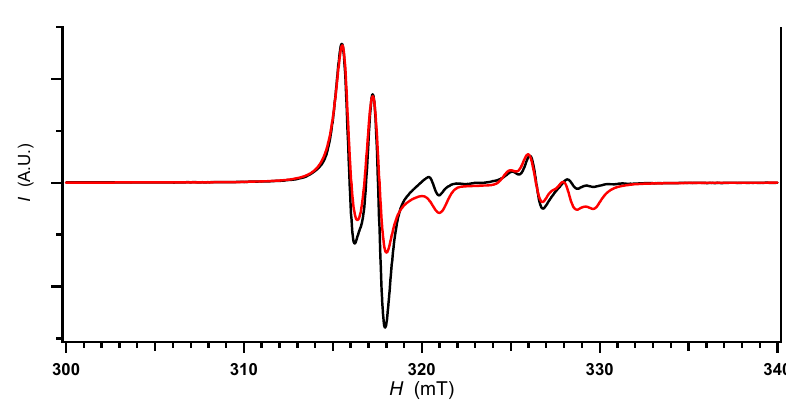
Figure 5. Electron spin resonance (ESR) spectra of γ -salt measured under dark and irradiated (254–450 nm) conditions. Black; observed spectra, red; simulated spectra. The observed spectra were completely identical and overlapped with each other under dark and irradiated conditions.